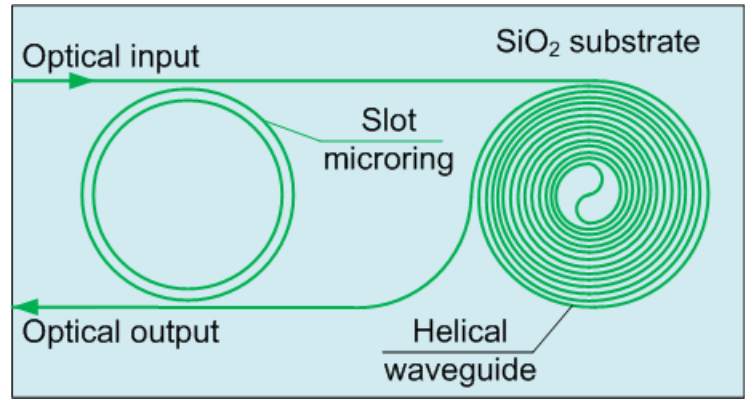
Figure 5. Schematic of slot microring gas sensor. Microring sensors are also frequently described for CO 2 detection [89]. Silicon mi- croring resonator with a radius of 10 um covered with a thin layer of the polyhexameth- ylene biguanide polymer, provided CO 2 gas concentrations measuring in the 0–500 ppm range with a sensitivity of 6 × 10 −9 RIU/ppm and a detection limit of 20 ppm. Table 2 pre- sents the recent advances in evanescent field absorption-based optical waveguide gas sen- sors. Table 2. Evanescent field absorption-based optical waveguide gas sensors. Platform